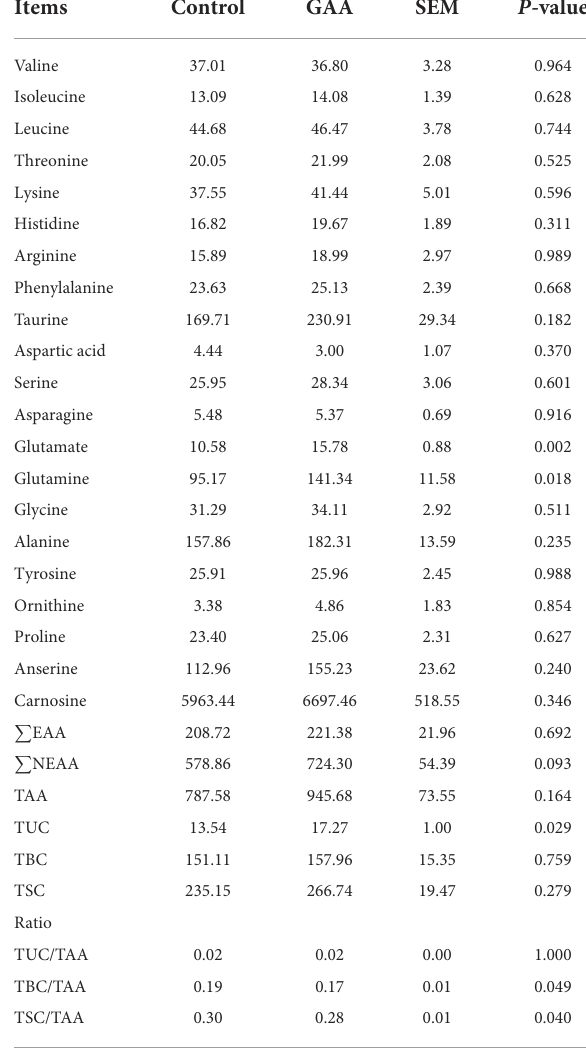
TABLE 3 Effect of dietary GAA on chemical composition and antioxidant status of Longissimus thoracis in Tibetan pigs. Items